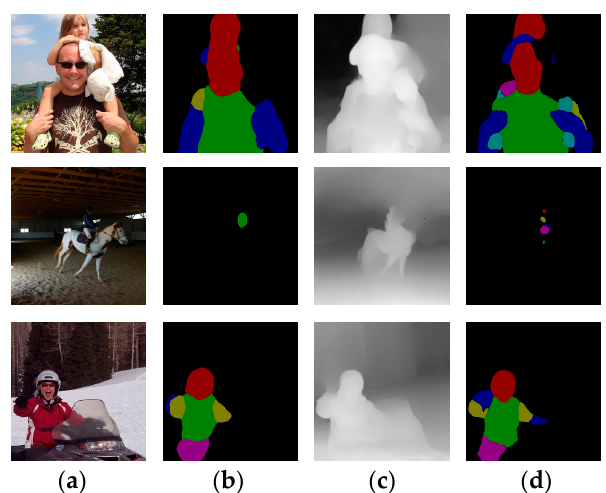
Figure 2. The improvement on segmentation is brought by the DM: ( a ) RGB images which are the input to both DM and SM; ( b ) The results of using the SM only for segmentation; ( c ) The predictions from the DM; ( d ) The results of integrating the SM with the DM for segmentation.